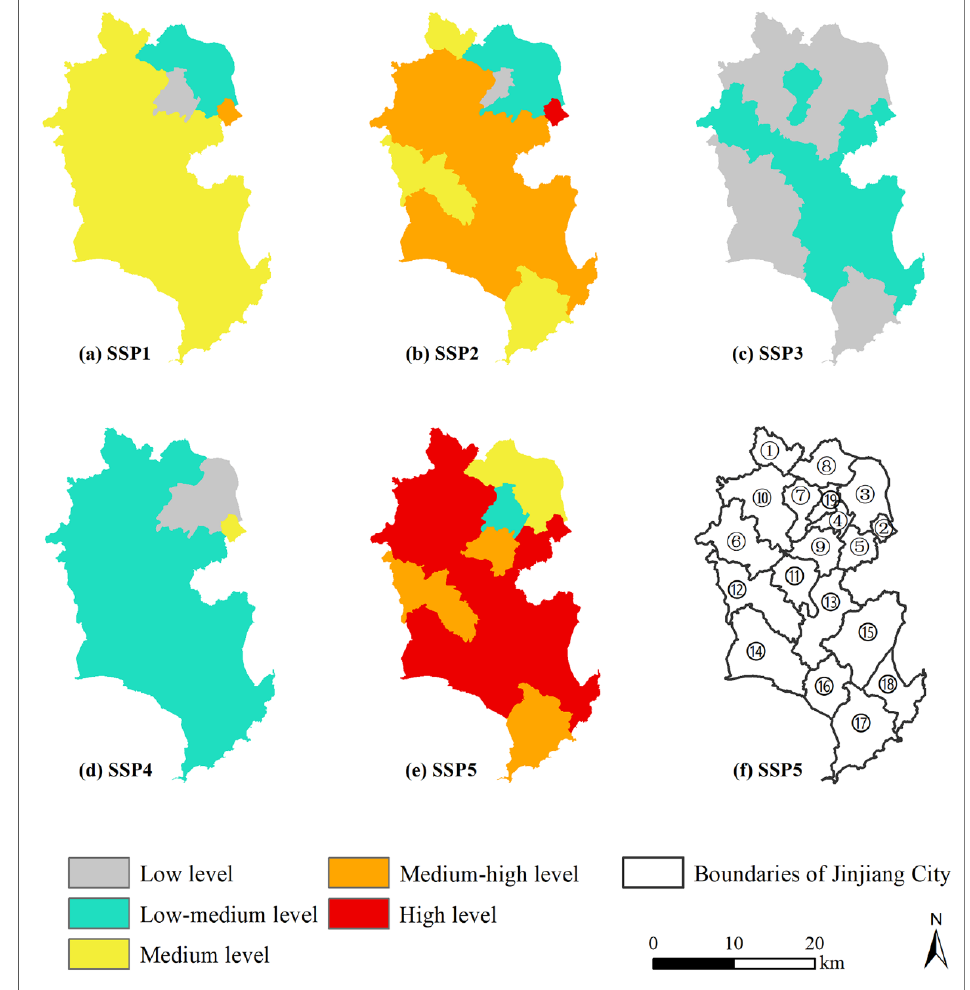
Figure 6. Spatial distribution of rate of expansion of Jinjiang City under the different SSP scenarios from 2020 to 2065. The town numbers in panel (f) are assigned as follows: 1 (cid:13) Zimao, 2 (cid:13) Xibin, 3 (cid:13) Chendai, 4 (cid:13) Qingyang, 5 (cid:13) Xintang, 6 (cid:13) Neikeng, 7 (cid:13) Xiyuan, 8 (cid:13) Chidian, 9 (cid:13) Luoshan, 10 (cid:13) Cizao, 11 (cid:13) Lingyuan, 12 (cid:13) Anhai, 13 (cid:13) Yonghe, 14 (cid:13) Dongshi, 15 (cid:13) Longhu, 16 (cid:13) Yinglin, 17 (cid:13) Jinjing, 18 (cid:13) Shenhu, and 19 (cid:13)